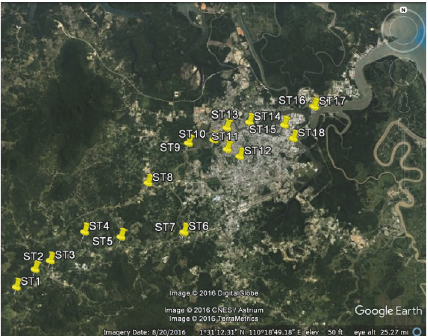
Figure 1: The sampling locations at the Sarawak River and its trib-